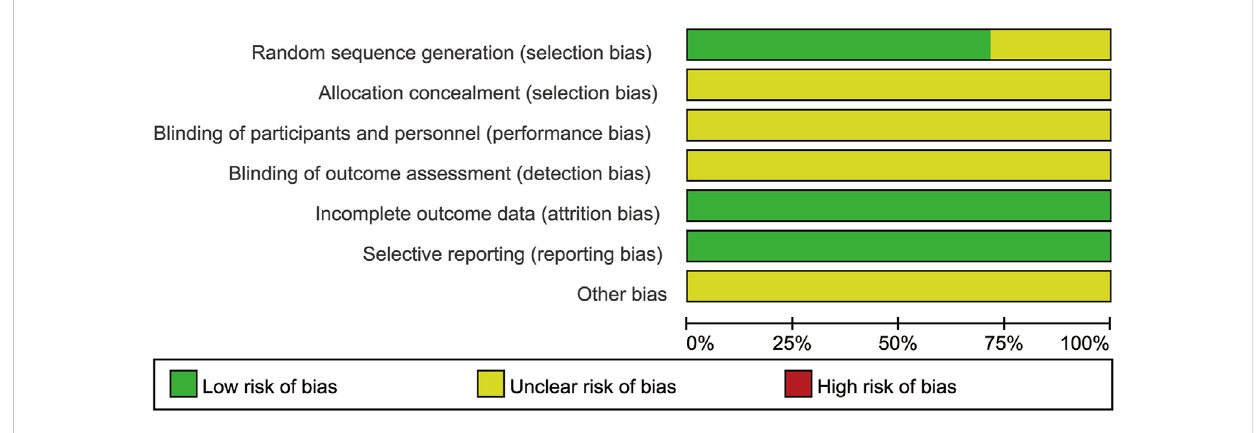
FIGURE 2 Bias risk